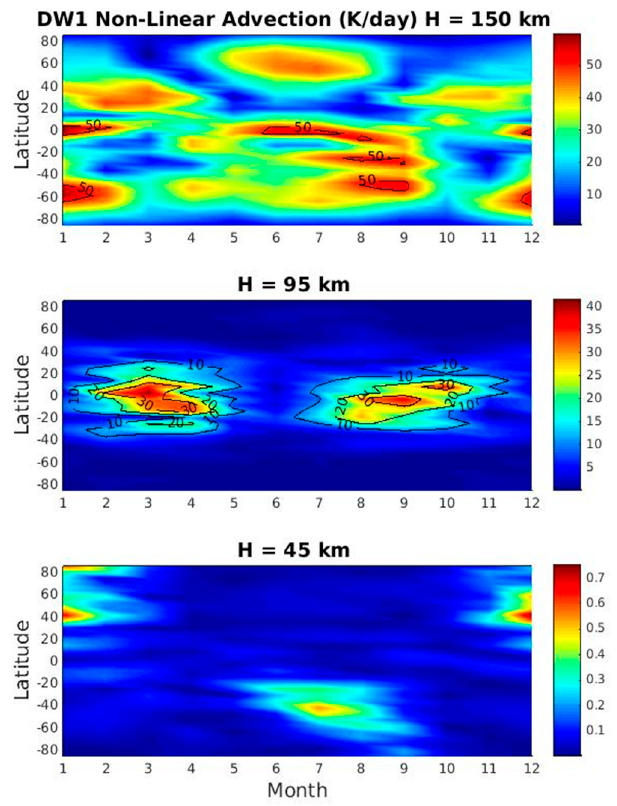
Figure 6. Same as Figure 5, but for the nonlinear advection term (wave-wave interaction).